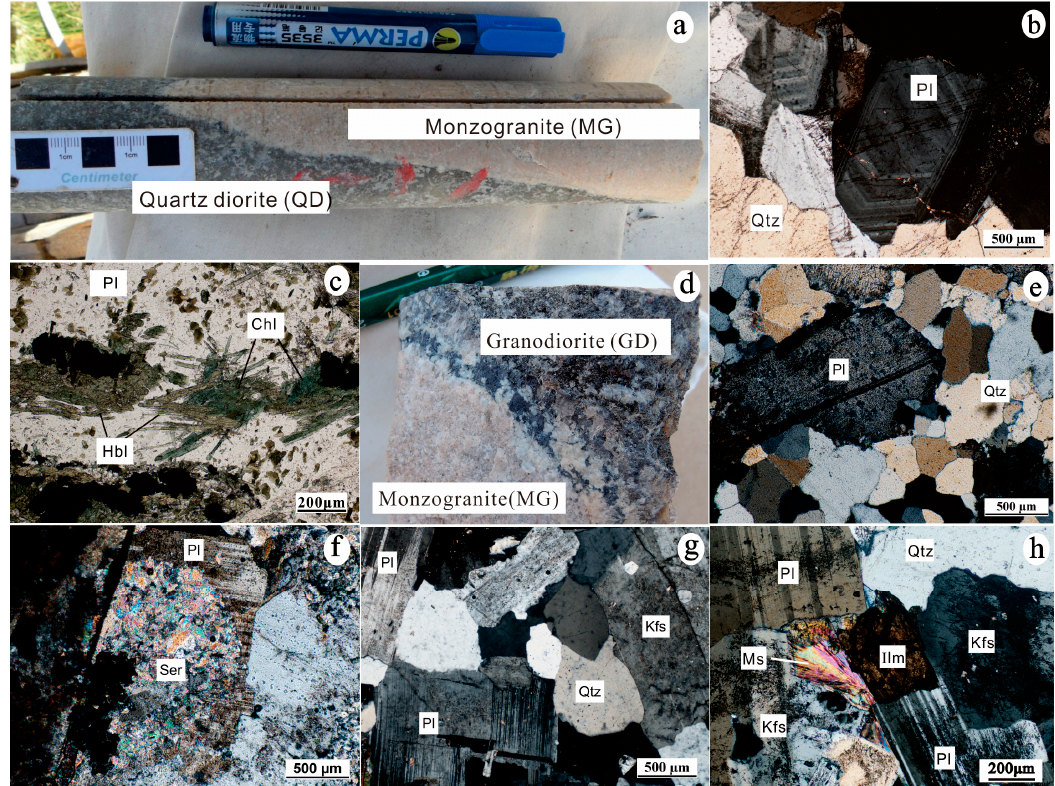
Figure 3. Hand samples ( a , b ) and photomicrographs (plane and cross polarized transmitted